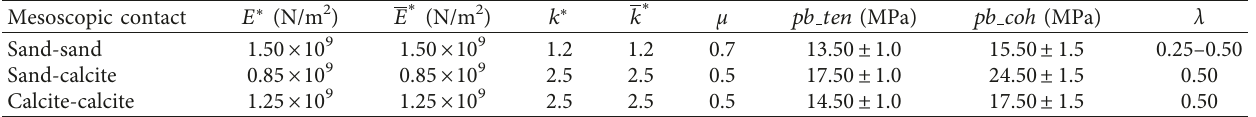
Table 2: Mesoscopic contact parameters.